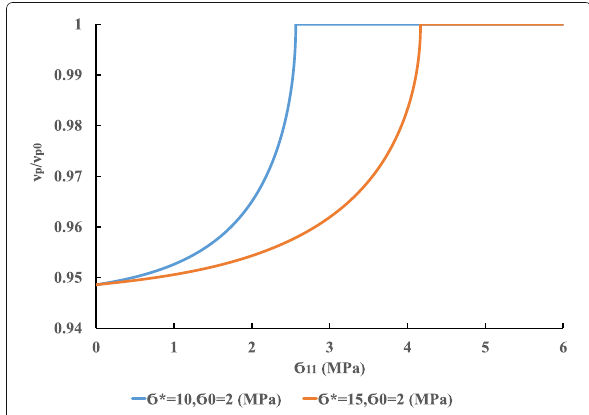
Stress σ 33 continuously varied in the interval between σ ∗ + σ σ ∗ − σ 0 and 0 with period l .